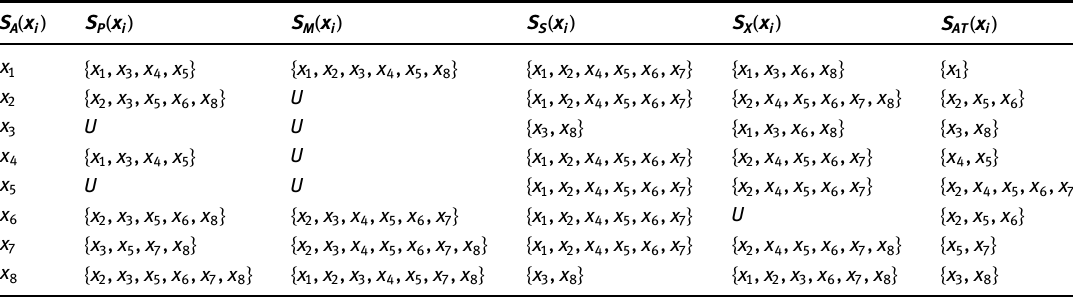
Table 3: The similarity classes of elements in Example